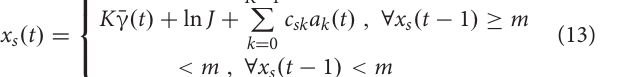
constant probability. Thus, the overall population dynamics